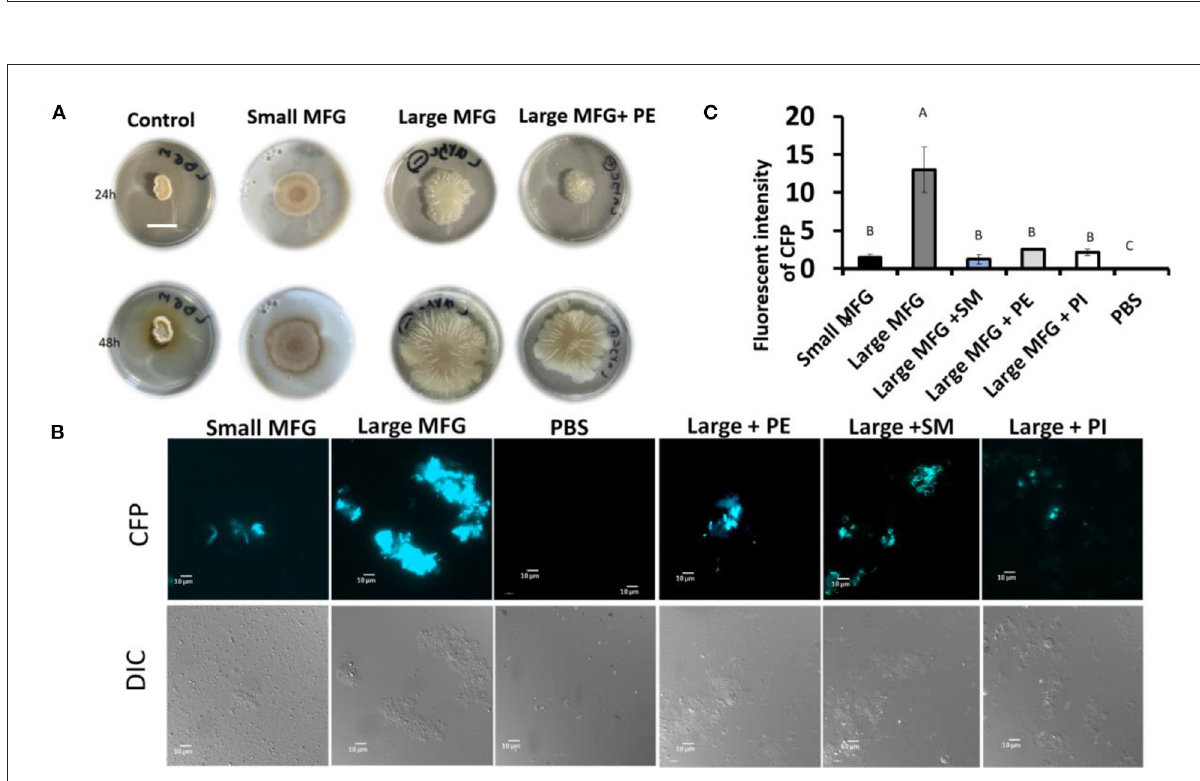
FIGURE7 Effect of supplementation of polar lipids on biofilm formation. Colony- or bundle-type [ (A, B) respectively] biofilms of B. subtilis grown on LBGM mixed with PBS or MFG of different sizes, compared to large MFG supplemented with PE, SM or PI in amounts matching those in the small MFG fraction. Addition of the MFGM PL (PE, SM, PI) to the large MFG (for comparison with the small MFG) a showed inhibited biofilm formation: (A) representative image of bacteria growth on LBGM mixed with milk fractions as substrate (1:1) Scale bar represent 1.5mm. The results indicate inhibitng of the colony type biofilm formation after incubation with the small MFG fractions and with large MFG with addition of PE. (B) representative image of cells was grown for 5h, 37 ◦ c and 50 RPM, and analyzed by fluorescent microscopy (C), relative fluorescence of the bundle-type biofilm was quantified. values are mean ± standard errors of 2 independent experiments with 3 replicates for each treatment in each experiment. Uppercase letters indicate significant differences between the treatment groups ( P ≤